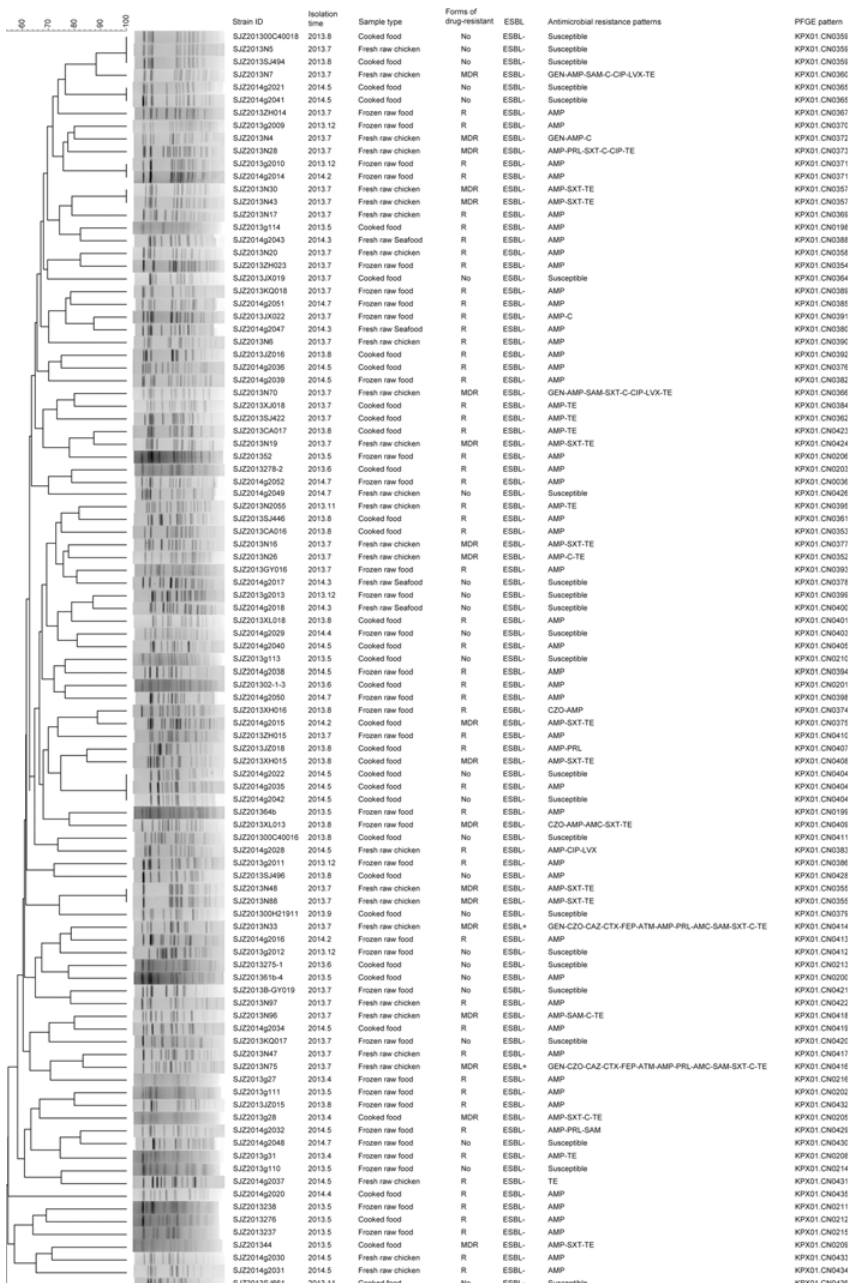
Fig 1. Clustering of the 99 K . pneumoniae Isolates Based on PFGE Patterns. The strain ID, isolation time, sample type, forms of drug-resistant, ESBL detection, antimicrobial resistance pattern, and PFGE pattern of each isolate are listed to the left of the patterns. In the column of “ forms of drug-resistant ” , “ No ” means not resistant to all drugs, “ R ” means non-susceptibility to at least 1 agent in one or two antimicrobial categories, “ MDR ” means non-susceptibility to at least 1 agent in 3 or more antimicrobial